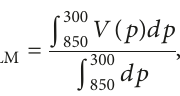
Figure 4: Time series of the MSLP (unit: hPa) and the MSWS (unit: m s 1200 UTC 27 August, respectively (unit: hPa; square line: JTWC best track; circle line: JMA best track; triangle line: CTL experiment; diamond line: NoT